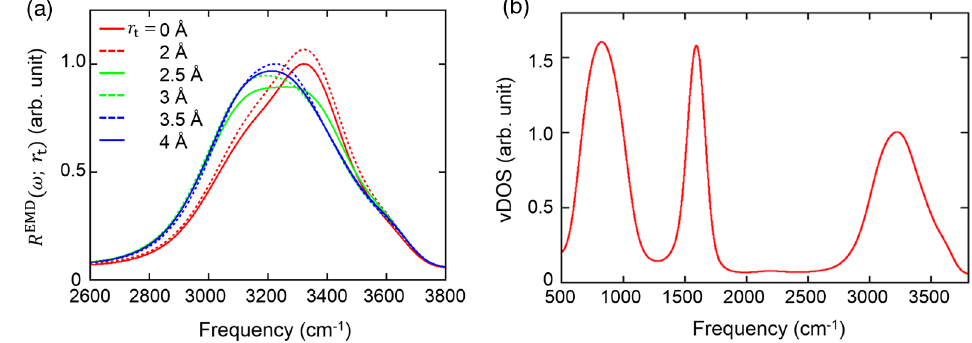
FIG. 1. (a) Calculated Fourier-transformed VCF spectra in the O-H stretch region. Variations of the Fourier-transformed VCF spectra Þ with various truncation radii r R EMD ð ω ; r t ¼ 3 . 5 Å. (b) Calculated Fourier-transformed VCF spectra in the spectral region ( 500 − 3800 cm − 1 ) with r r t